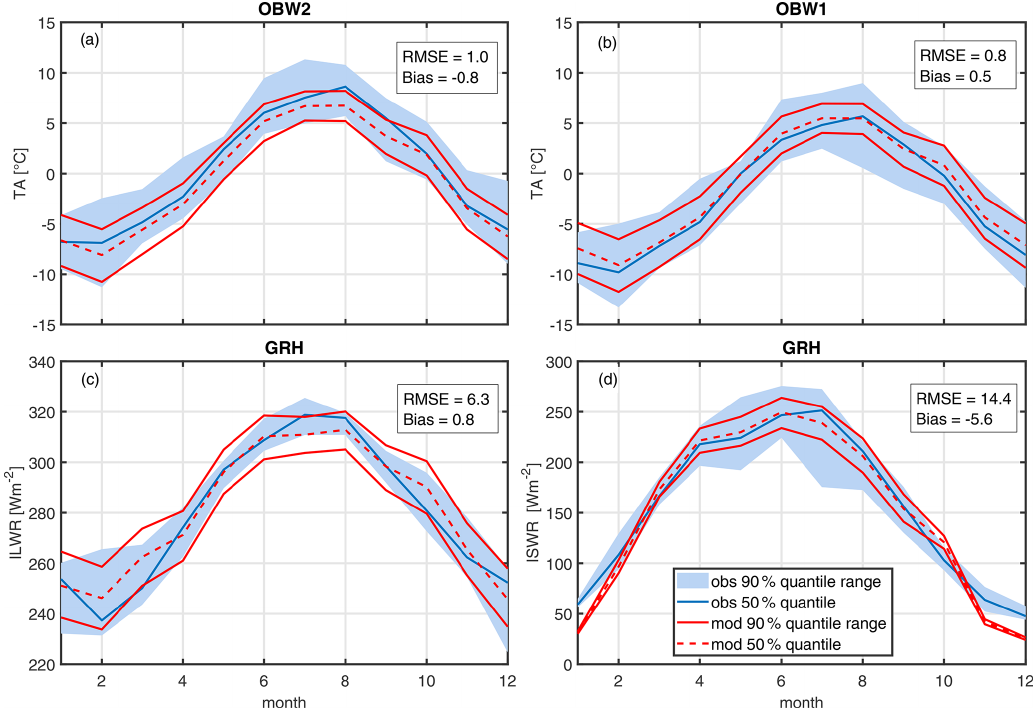
Figure 3. Monthly mean values for (a) air temperature ( T A ) at the stations OBW2 and (b) OBW1, (c) incoming longwave radiation (ILWR), and (d) incoming shortwave radiation (ILWR) (d) at station GRH. Plotted are 5th, 50th and 95th percentiles of observations in blue of 8 years (GRH) and 20 years (OBW1, 2) and modelled data in red of 1500 years. RMSE and bias are calculated for 50th percentiles.